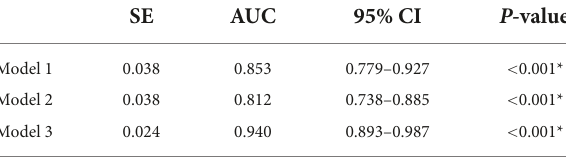
TABLE 5 Comparison of different models to predict PSCI in ICH